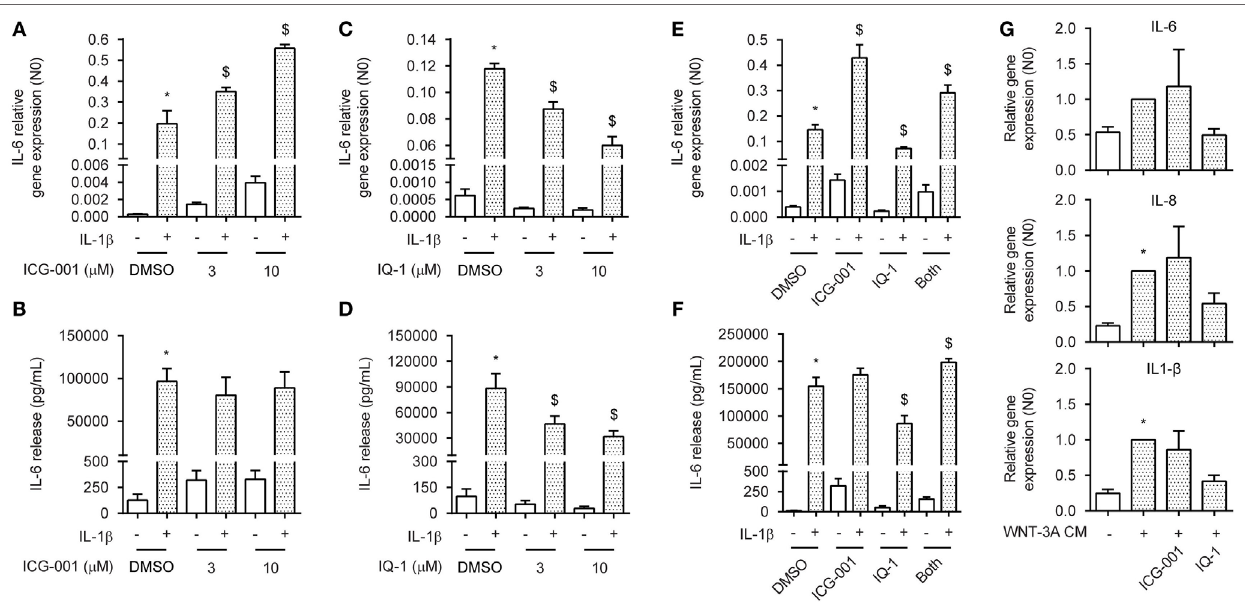
FigUre 4 | CREB-binding protein (CBP) and p300 convey interleukin-1 β (IL-1 β )-responsiveness via β -catenin. (a) IL-6 mRNA and (B) secreted protein from airway smooth muscle cells exposed to IL-1 β (1 ng/mL) for 16 h (a) or 24 h (B) with or without ICG-001 (3 and 10 µM). RNA was isolated and subjected to RT-qPCR (a) whereas cell supernatants were subjected to enzyme-linked immunosorbent assay (ELISA) (B) . Data represent four (a) and six (B) independent experiments. (c) IL-6 mRNA and (D) secreted protein as in (a,B) , but treated with IQ-1 (3 and 10 µM). Data represent four (c) and six (D) independent experiments. (e) IL-6 mRNA and (F) secreted protein as in (a,B) , but treated with ICG-001 (10 µM), IQ-1 (10 µM) or the combination. Data represent four (e) and six (F) independent experiments. (g) IL-6, IL-8, and IL-1 β mRNA of airway smooth muscle exposed to WNT-3A conditioned medium (100%) for 18 h with or without DMSO, ICG-001 (10 µM), or IQ-1 (10 µM). Data represent seven independent experiments. * vs. control and $ vs. IL-1 β